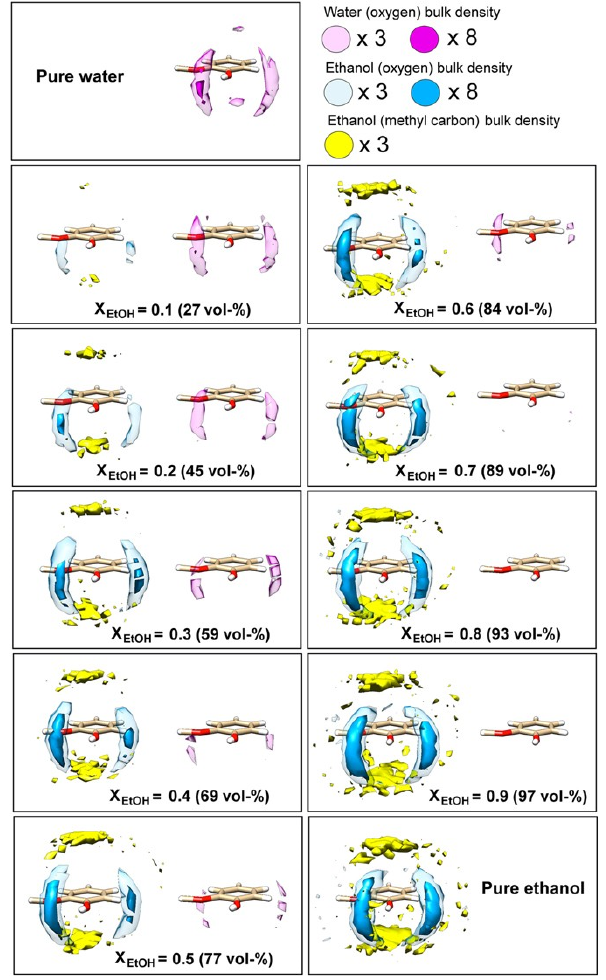
Figure 5. Solvent affinity of water and EtOH for guaiacol. Atomic spatial distribution functions (SDFs) of water oxygen and EtOH oxygen and methyl carbon components around a single guaiacol molecule in liquid–air interface mixtures of varying EtOH content. Reprinted with permission from Ref. [32]. Copyright 2017, The Author(s).